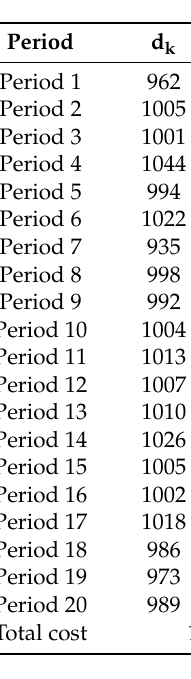
Table 1. Case 1: Production plan for individual maintenance